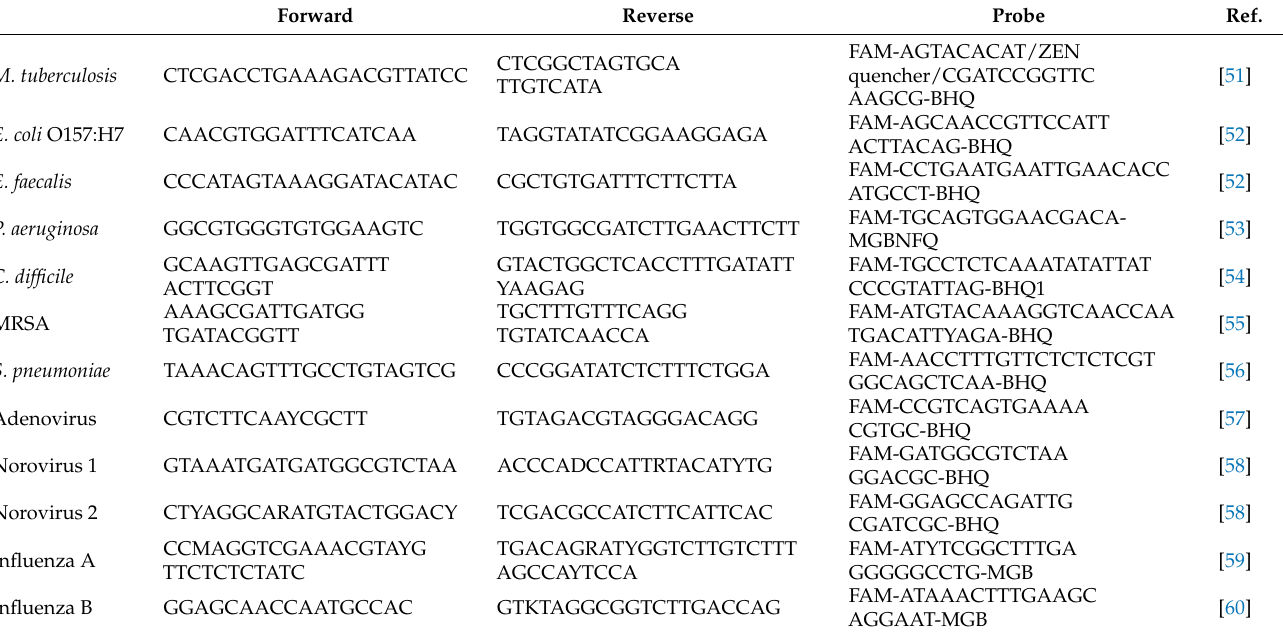
Table 2. Primers and probes (5 (cid:48) -3 (cid:48) ) used for detection of nucleic acids on surfaces. Forward Reverse Probe